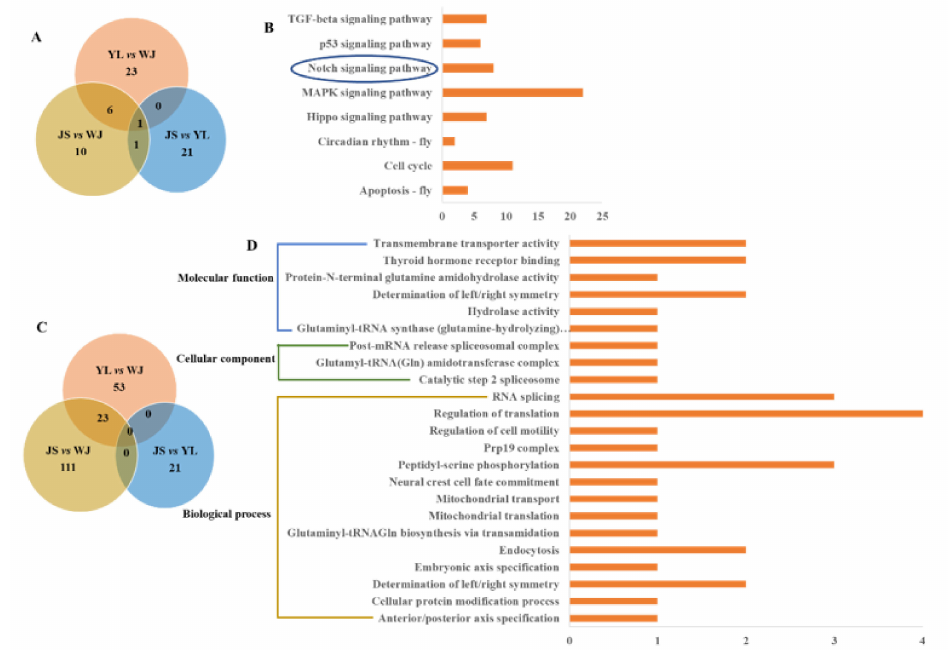
Figure 5. Functional annotations of the selected SNPs based on KEGG pathways and GO terms. ( A ) Venn diagram of significant KEGG pathways; ( B ) six common signaling pathways; ( C ) Venn diagram of significant GO terms; ( D ) 23 common GO terms. YL, Yalong River; JS, Jinsha River; WJ, Wujiang River. The Notch signaling pathway was common in the YL vs. WJ, JS vs. WJ, and JS vs. YL